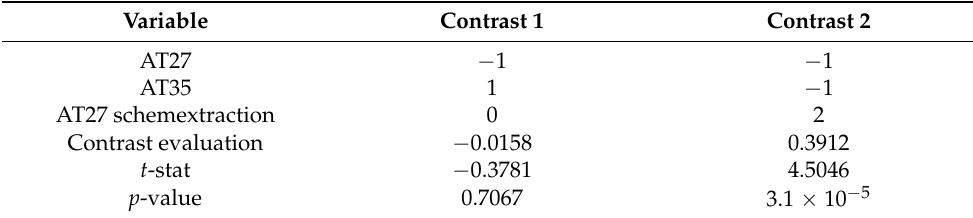
Table 6. Contrast analysis for marginal average.